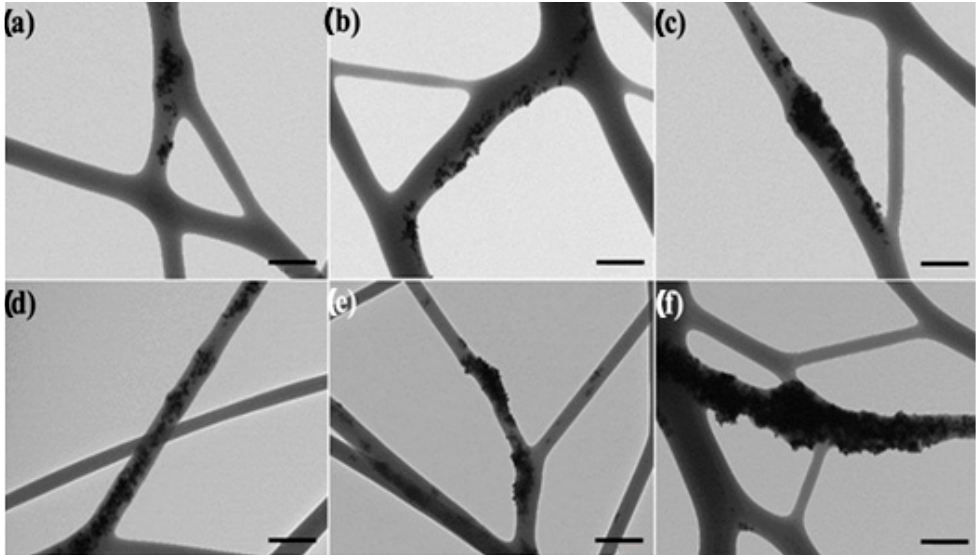
Figure 4. Comparison of the nanoparticles dispersion within the electrospun poly(3-hydroxybutyrate-co-3-hydroxyvalerate) (PHBV) fibers: ( a ) 0.5 wt.% CeO 2 NPs; ( b ) 1.0 wt.% CeO 2 NPs; ( c ) 1.5 wt.% CeO 2 NPs; ( d ) 2.0 wt.% CeO 2 NPs; ( e ) 5.0 wt.% CeO 2 NPs; ( f ) 10.0 wt.% CeO 2 NPs. Micrographs were taken by transmission electron microscopy (TEM). Scale bar 400 nm.